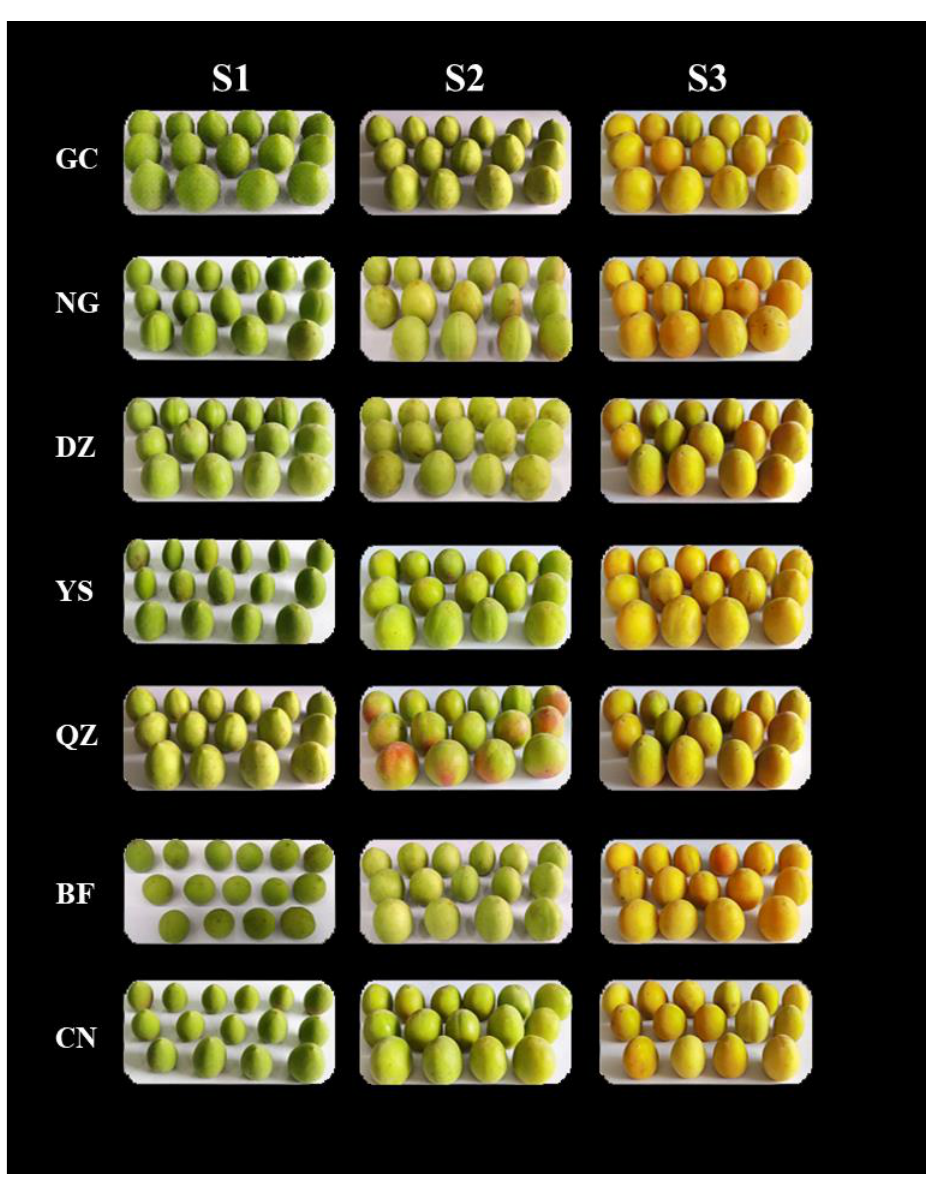
Figure 1. Seven representative and superior green plum varieties harvested at levels immature (S1), commercially mature (S2), and fully mature